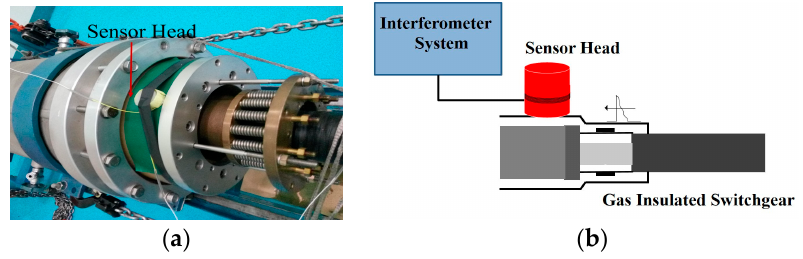
Figure 8. Photograph and experimental setup of the 220 kV model GIS, ( a ) a photograph of 220 kV GIS; ( b ) Experimental setup of the 220 kV model Gas Insulated Switchgear (GIS).